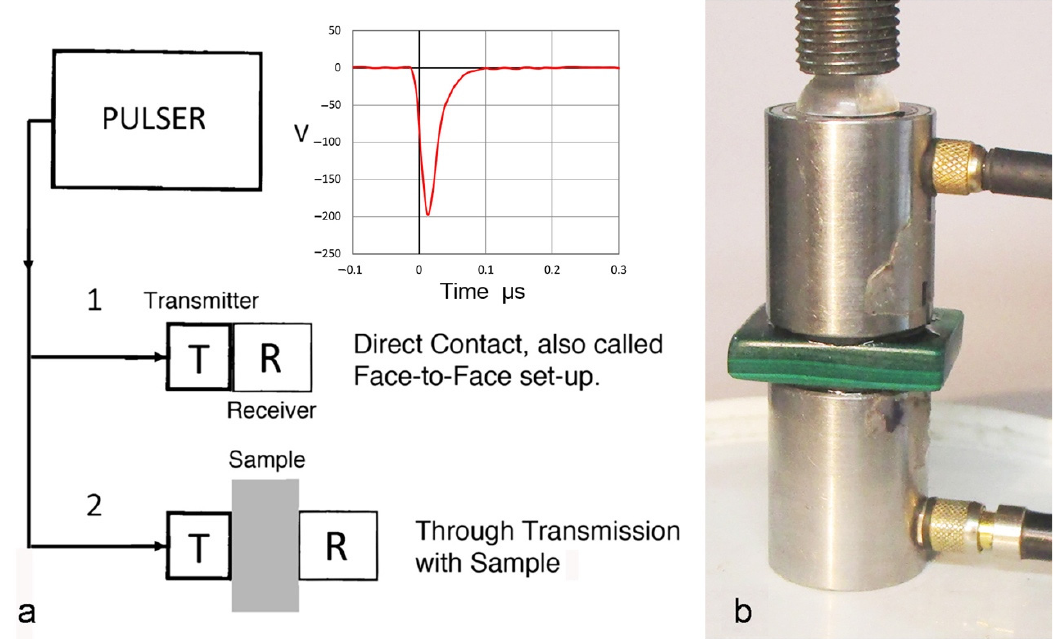
Figure 6. ( a ) Schematics of the attenuation experiment. Top: pulser with output waveform. 1: direct contact test. 2: through ‐ transmission test. ( b ) Photograph of the test jig with malachite sample between two 10 ‐ MHz transducers. Transducers are manually aligned and pressed together using a 12.7 mm diameter bolt and a hemisphere. Finger ‐ tightening of the bolt generates ~200 N force.